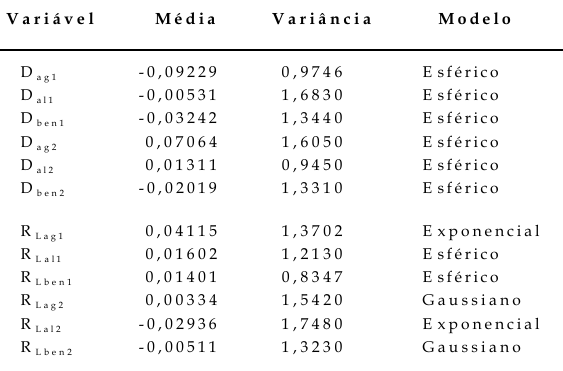
= tamanho do maior agregado para o diâme- to com álcool; R Lben2 tro médio da peneira de > 2 mm no pré-tratamento com benzeno. e para a L